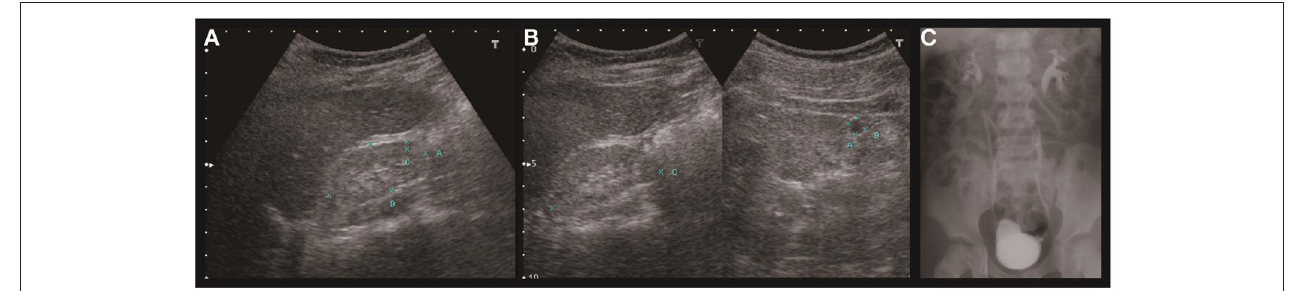
FIGURE 1 | Renal ultrasound and voiding cystoureterography of case A. Sonography of the right (A) and left (B) kidney revealed hypoplasia and hyperechogenicity of bilateral kidneys. The right kidney measured 4.6cm in length and left kidney 4.9cm. A cyst was found in the left kidney. Voiding cystoureterography (C) revealed bilateral vesicoureteral reflux (right side grade II, left side grade III).